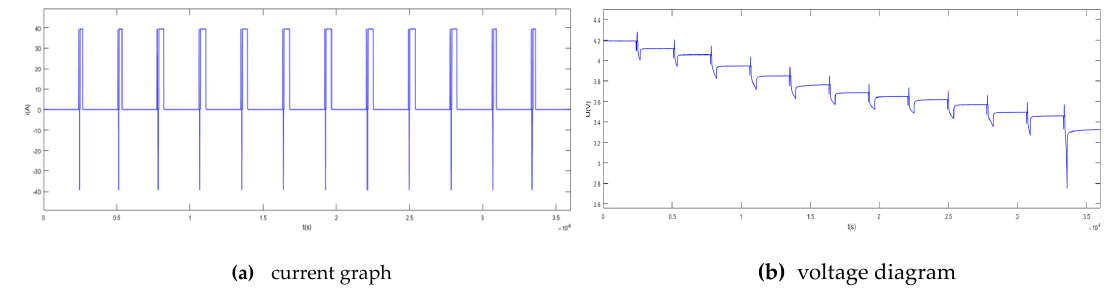
Figure 5. HPPC experiment of the discharge process.